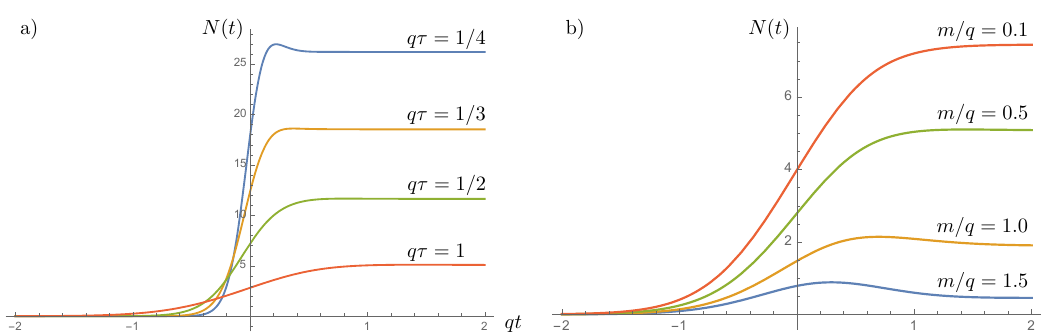
Figure 2 . Evolution of the total number of particles plus antiparticles for values of q(cid:28) and m=q = 0 : 5. b) Di(cid:11)erent values of m and q(cid:28) =